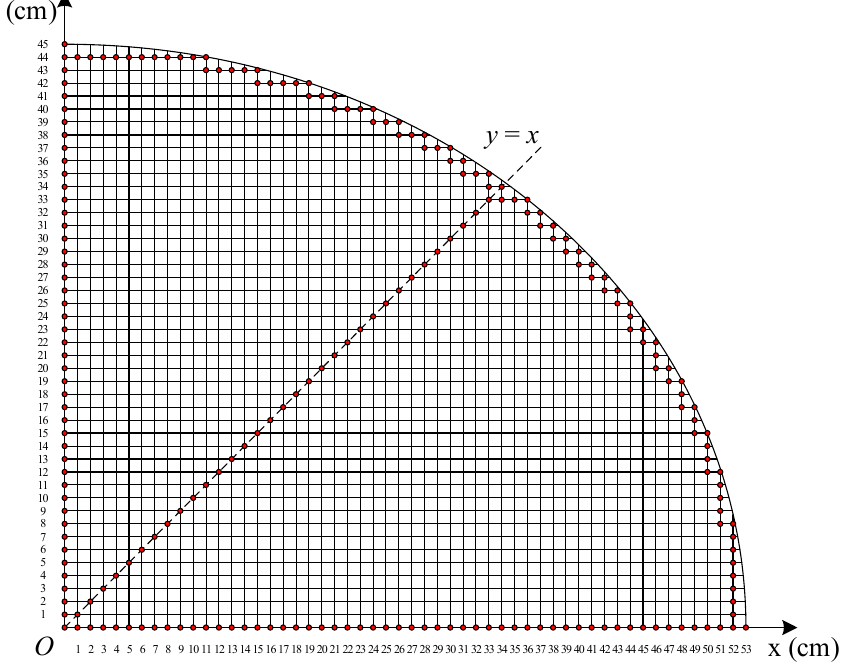
Figure 19. Horizontal positions for positioning accuracy verification.